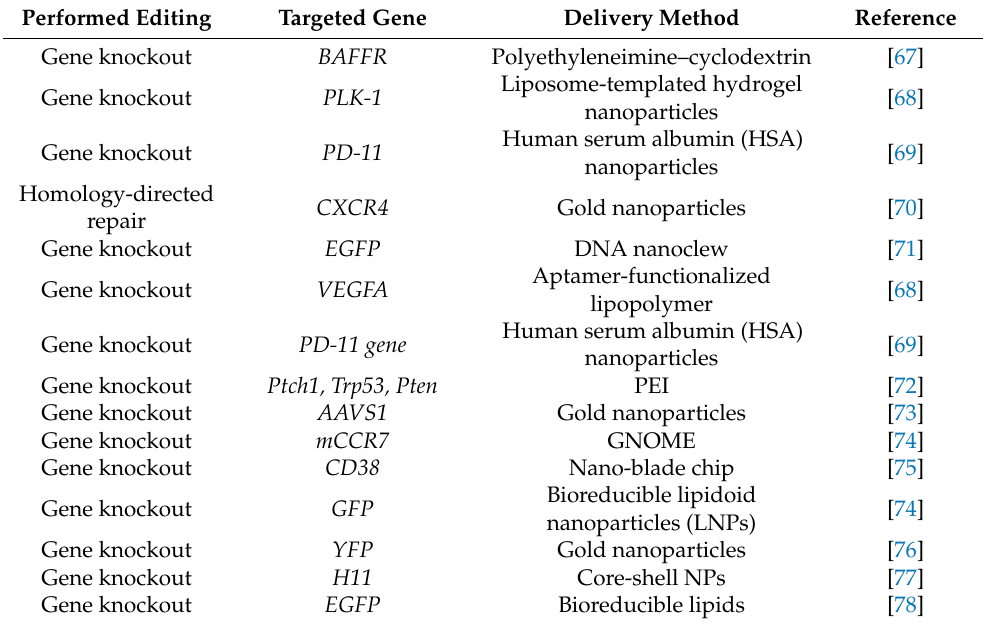
Table 1. Successful reports of nanoparticle-based delivery of